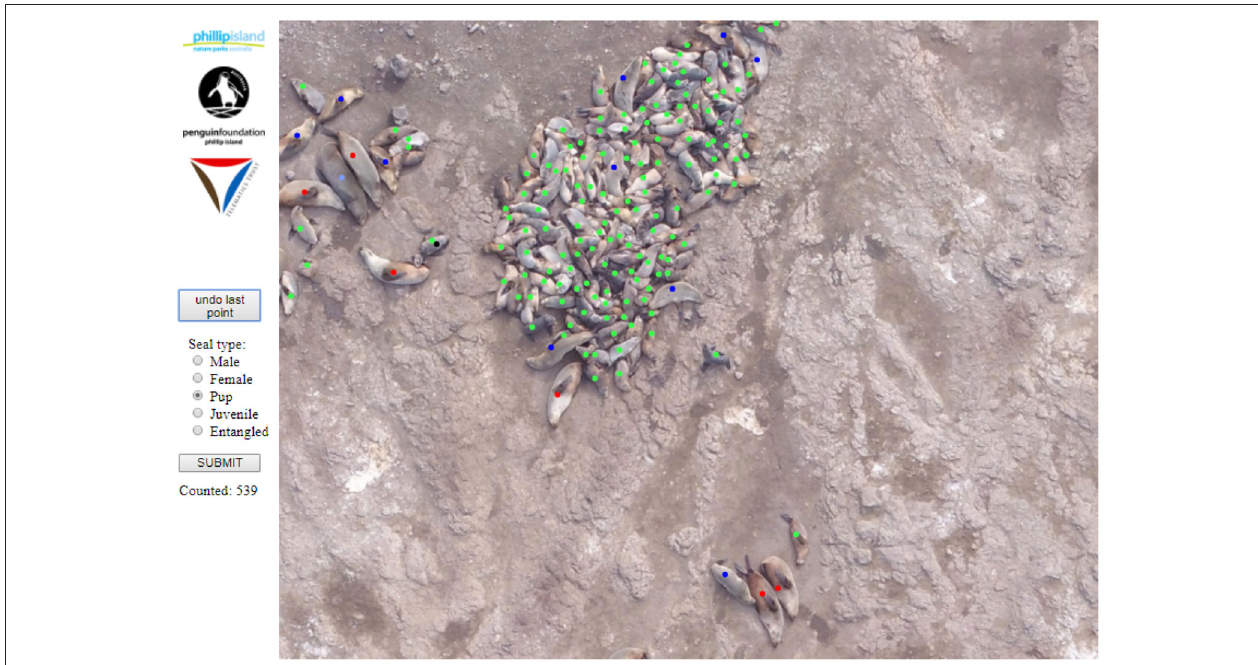
FIGURE 3 | Screenshot of “SealSpotter” web portal. Users select animal types using radio buttons in the left side panel, then mark animals on the image before submitting the data for storage on the server, and subsequent collation and analysis. User name, precise click timestamps, and user comments, are also collected as part of this